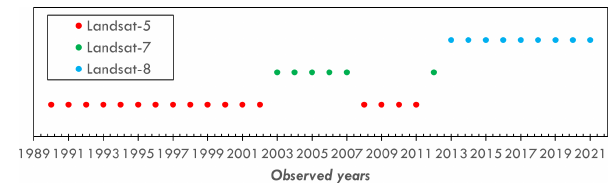
Figure 1. Landsat archives used for depositional zones of avalanche detection since